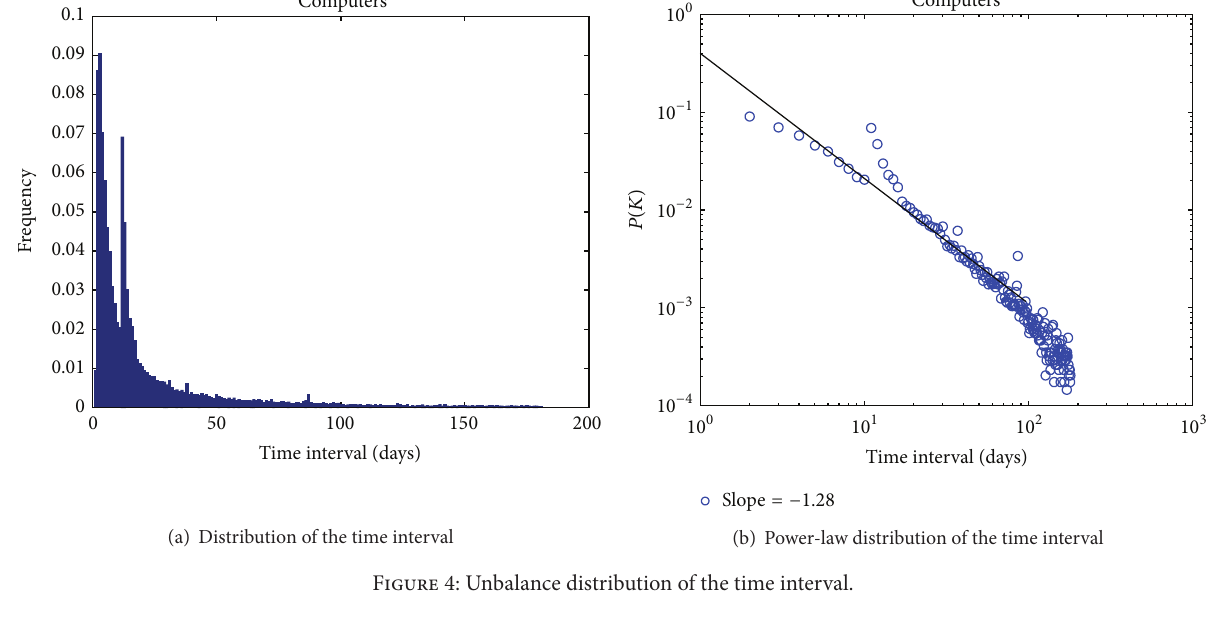
Figure 4: Unbalance distribution of the time interval.